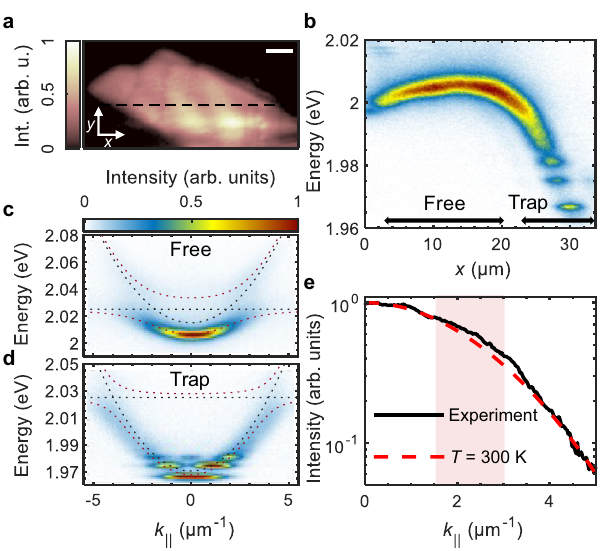
Fig. 2 Potential landscape and polariton dispersion. a PL map of the monolayer region inside the microcavity, where x and y mark the directions along and perpendicular to the spectrometer slit, respectively. Scale bar = 5 μ m. b PL spectrum at approximately zero in-plane momentum ( k ∣∣ ≈ 0) across the dashed line in panel a . c , d Polariton dispersion extracted from the angle-resolved photoluminescence spectra of the sample ( c ) in the “ planar ” region with a weak potential gradient (marked “ Free ” in b ) and d in the trap region (marked “ Trap ” in b ). The fl at (parabolic) black dotted lines correspond to the exciton (cavity photon) energies and the upper (lower) red dotted lines are the fi tted upper (lower) polariton branches with the Rabi splitting 2 ℏ Ω ≈ 25meV. e Intensity pro fi le of the PL spectrum in c with the theoretical intensity pro fi le of a fully thermalised polariton gas at T = 300K. The bottleneck region of the free polariton dispersion (between k ∣∣ ≈ 1.5 μ m − 1 and k ∣∣ ≈ 3 μ m − 1 ) is shaded.